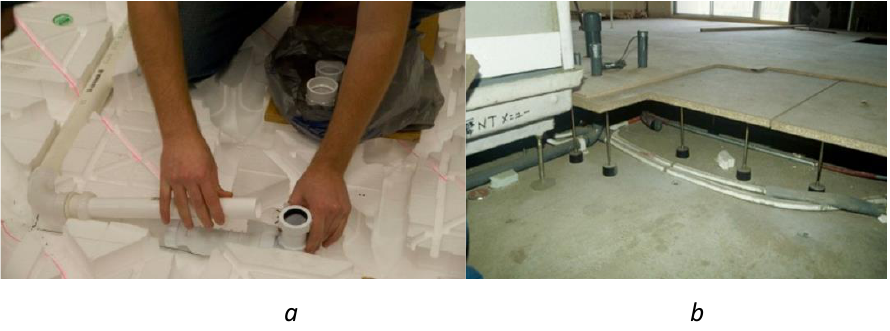
Figure 9 Matrix tile system and raised floor system applications (a: Kendall, 2016 b: Fukao,